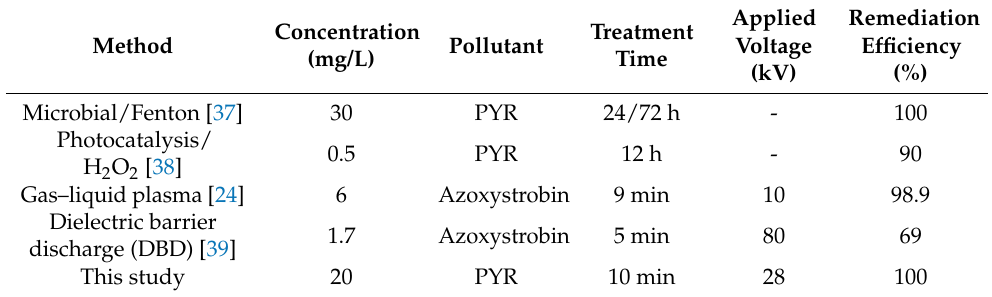
Table 1. Briefly compare the removal efficiency of different methods to remove Strobilurin